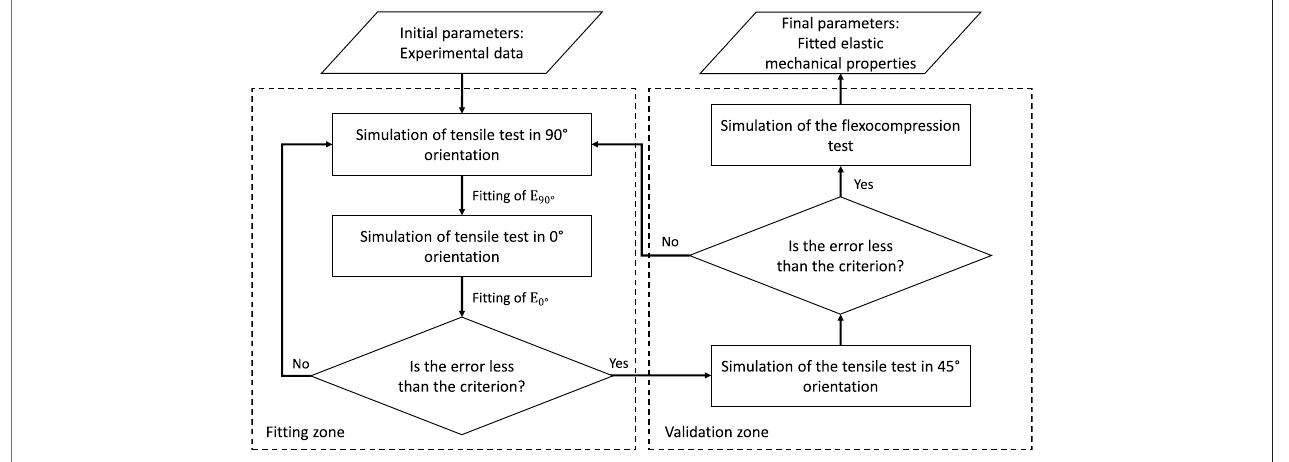
FIGURE 5 | Flowchart of the fi tting procedure of elastic properties through numerical